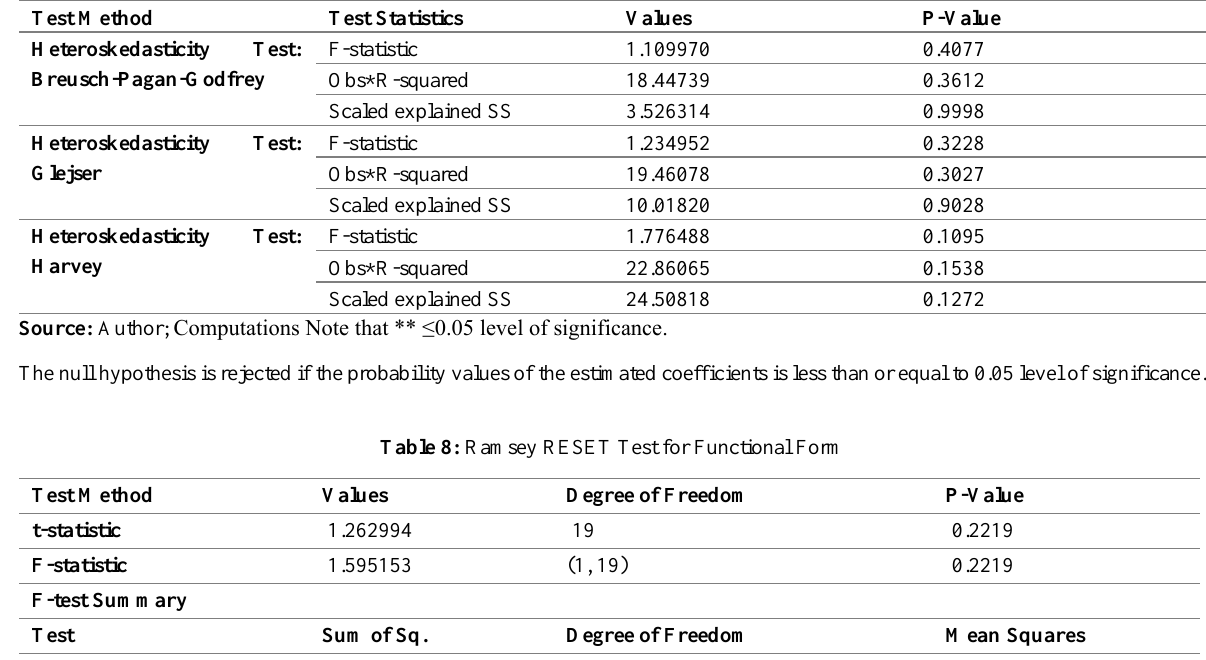
Table 7: Results of Test for Heteroscedasticity